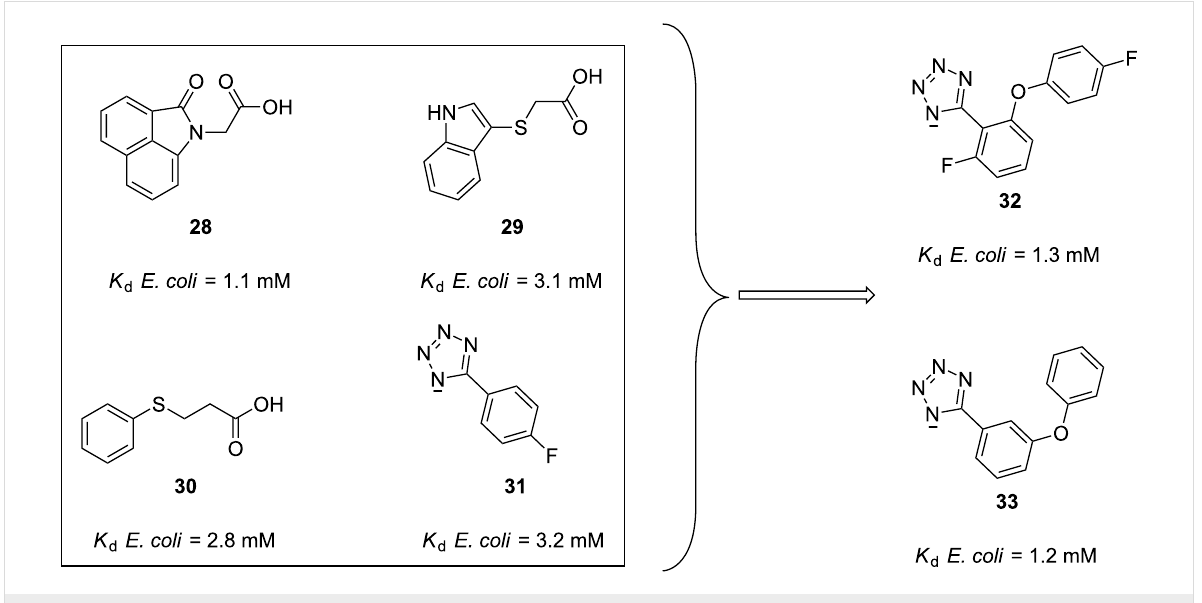
Figure 7: SSB protein–protein interaction inhibitors identified by FBDD.